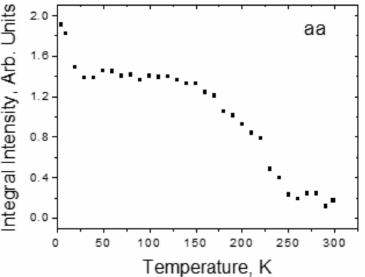
Figure 18. Relative integral intensity of the 930–980 cm − 1 band as a function of crystal temperature. Short O-H ··· O bonds in the crystal form infinite chains along the a axis; however,